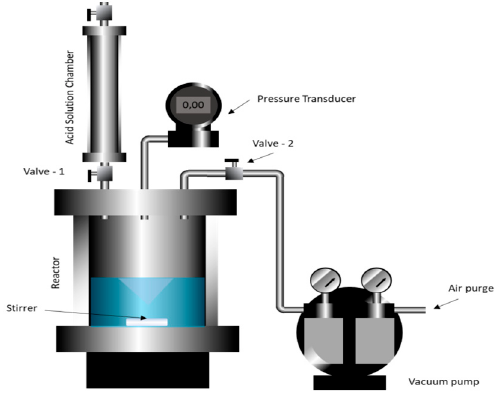
Figure 20. Reactor scheme.